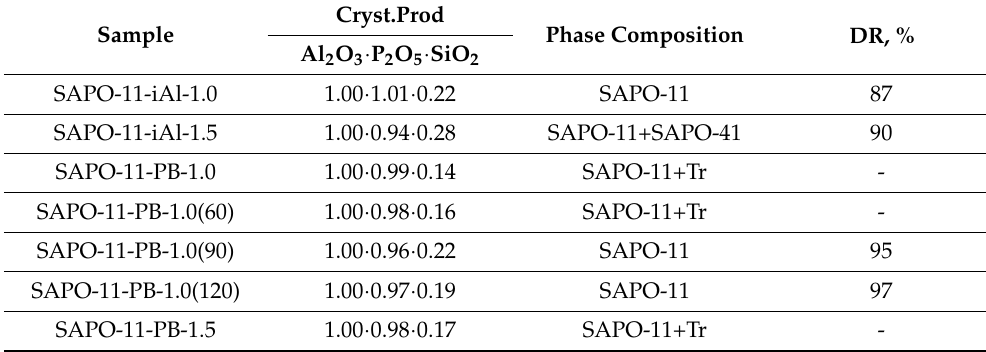
Table 2. Chemical and phase composition of crystallization products.